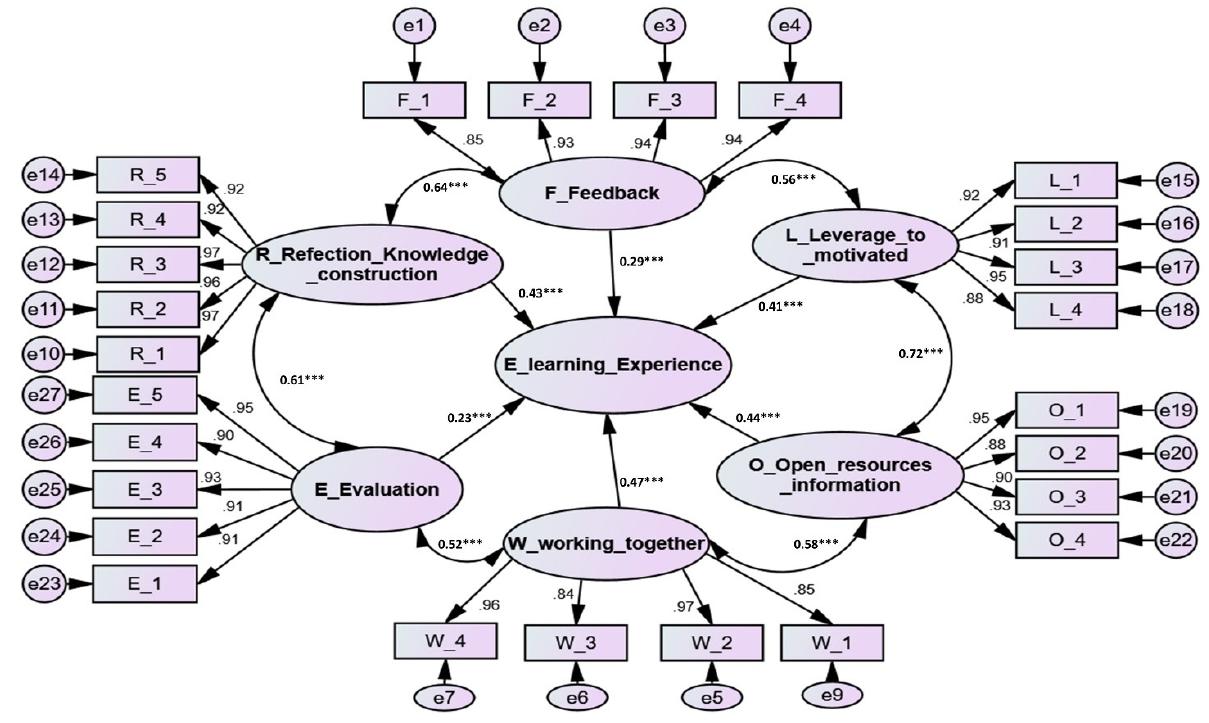
Figure 1. Structural model. Note: ***: significant level less than 0.001